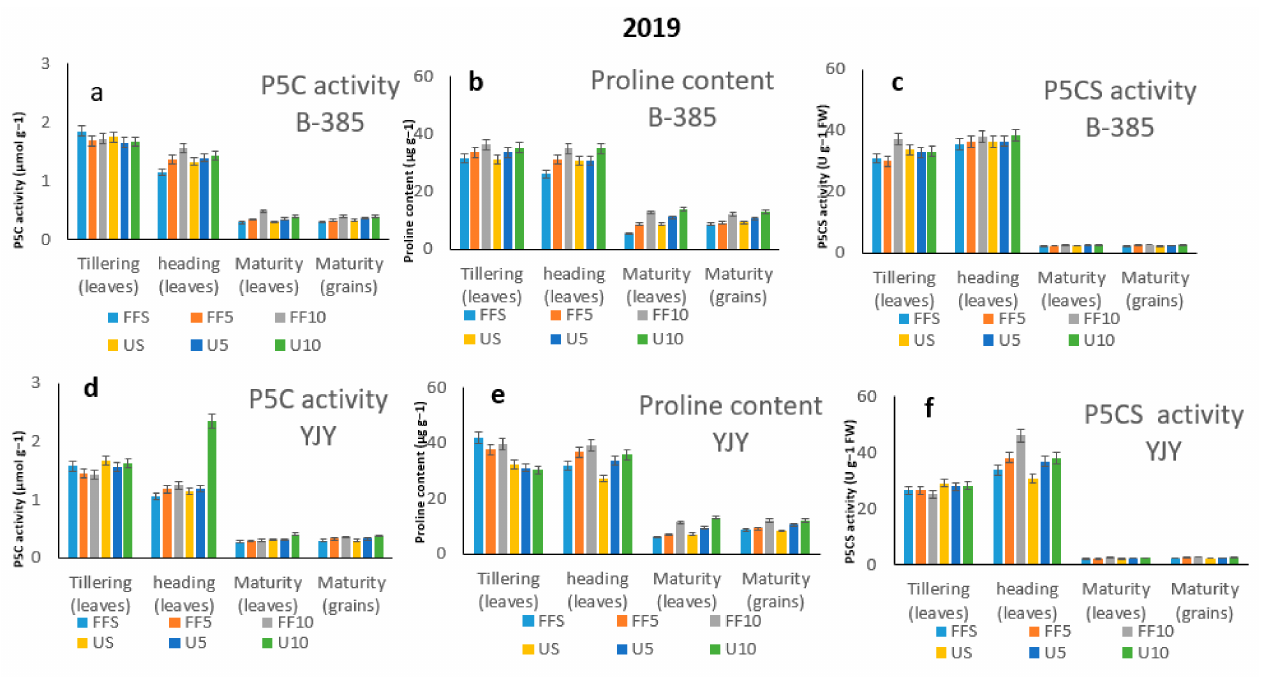
Figure 5. Aroma-related substances’ activities in the leaves and grains at different growing stages under fertilizer application in 2019. ( a ) P5C activity ( µ mol g − 1 ) in B-385 rice cultivar under different fertilizer application; ( b ) Proline content ( µ g g − 1 ) in B-385 rice cultivar under different fertilizer application; ( c ) P5CS activity (U g − 1 FW) in B-385 rice cultivar under different fertilizer application; ( d ) P5C activity ( µ mol g − 1 ) in YJY rice cultivar under different fertilizer application; ( e ) Proline content ( µ g g − 1 ) in YJY rice cultivar under different fertilizer application; ( f ) P5CS activity (U g − 1 FW) in B-385 rice cultivar under different fertilizer application.